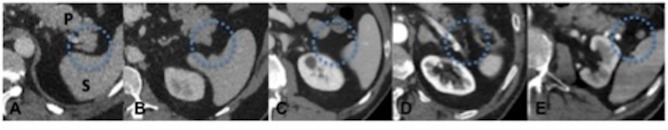
Age-related development of the PLG in the control group.The PLG is age correlated and increases by 0.8 mm within 10 years (P: pancreas, S: spleen). A: age group 40–50 y. B: age group 50–60 y, C: age group 60–70 y, D: age group 70–80 y, E: age group 80–90 y.